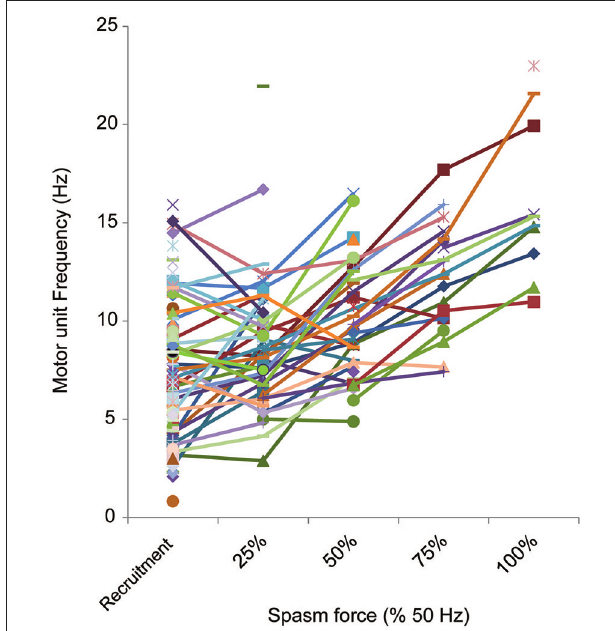
FIGURE 6 | Motor unit firing rate at different force levels (% 50 Hz force) . The firing rate of motor units (reciprocal of the mean of 3 interspike intervals) at each 25% force step was plotted, starting at recruitment. Not all spasms attained the force evoked by 50 Hz stimulation or units could not be followed up to maximal force.